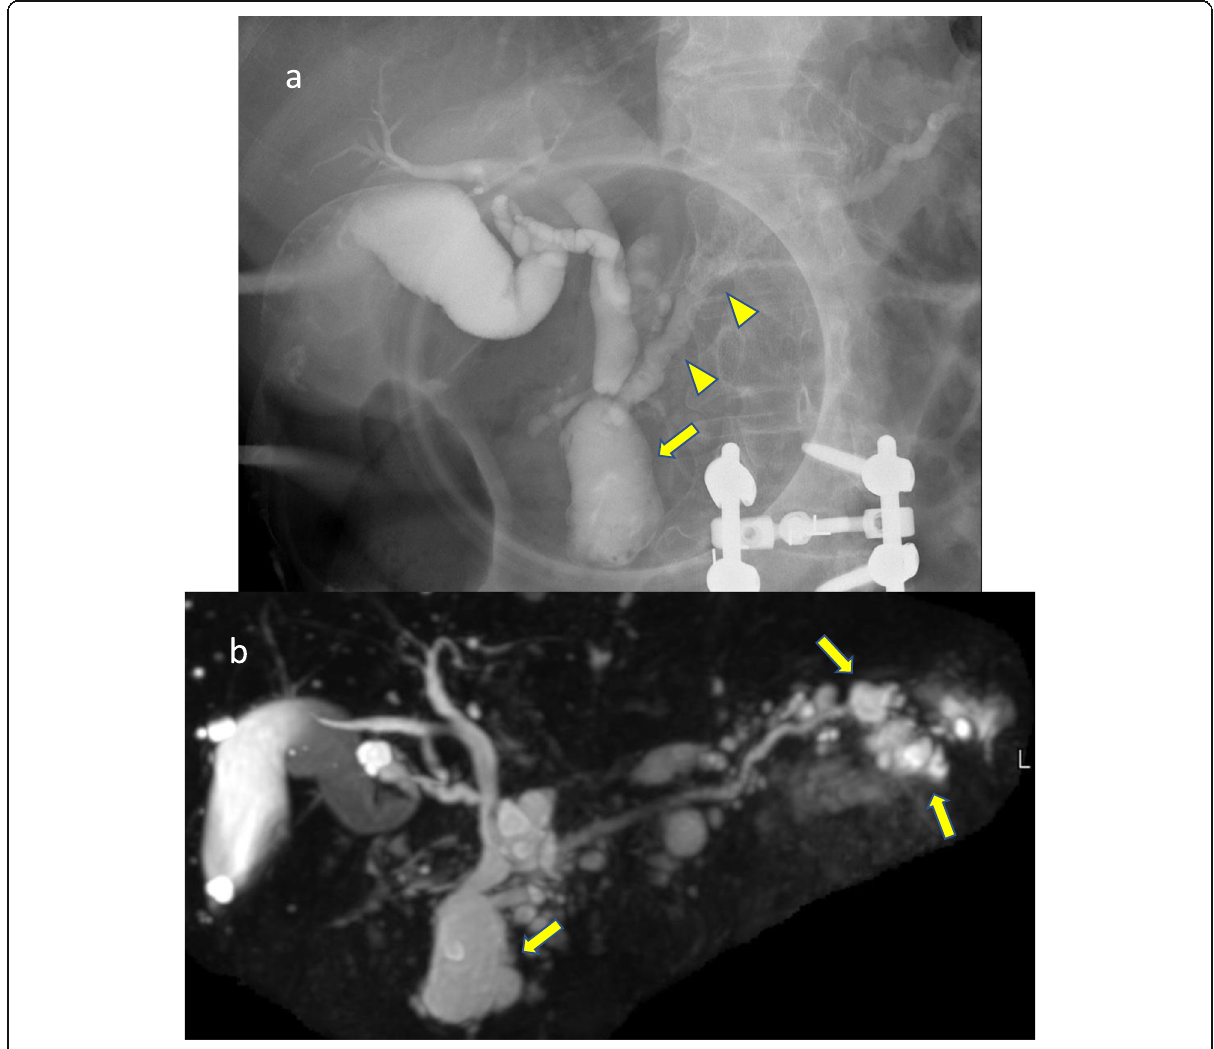
Fig. 1 Cholangiopancreatographic images. a Endoscopic retrograde cholangiopancreatographic image. b Magnetic resonance cholangiopancreatographic image. Arrows: branch duct intraductal papillary mucinous neoplasm (IPMN). Arrowheads: main duct